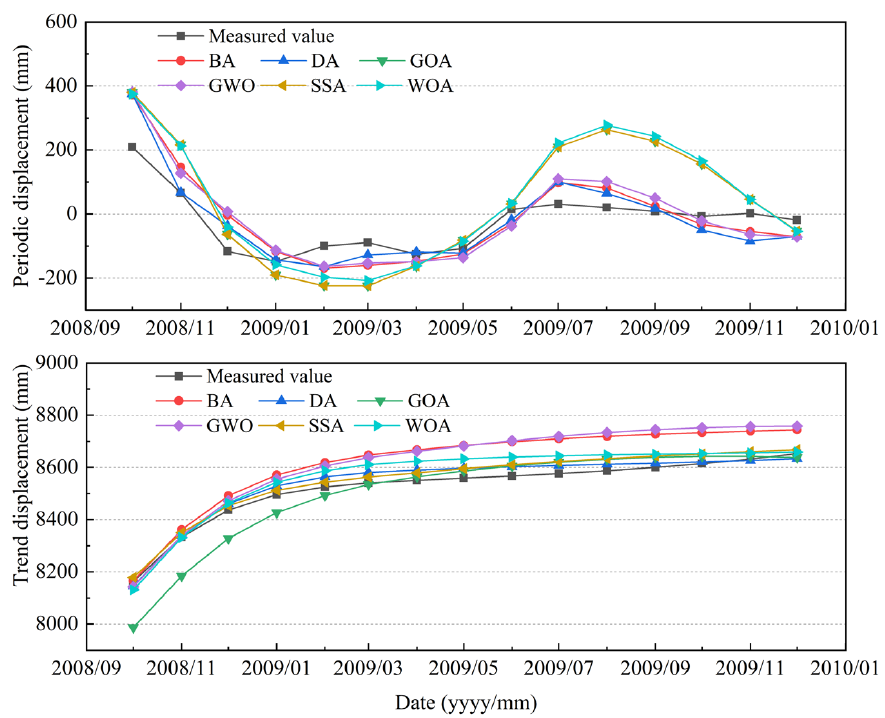
Figure 15. Comparison of prediction results by MSI-SVR model with monitoring data.